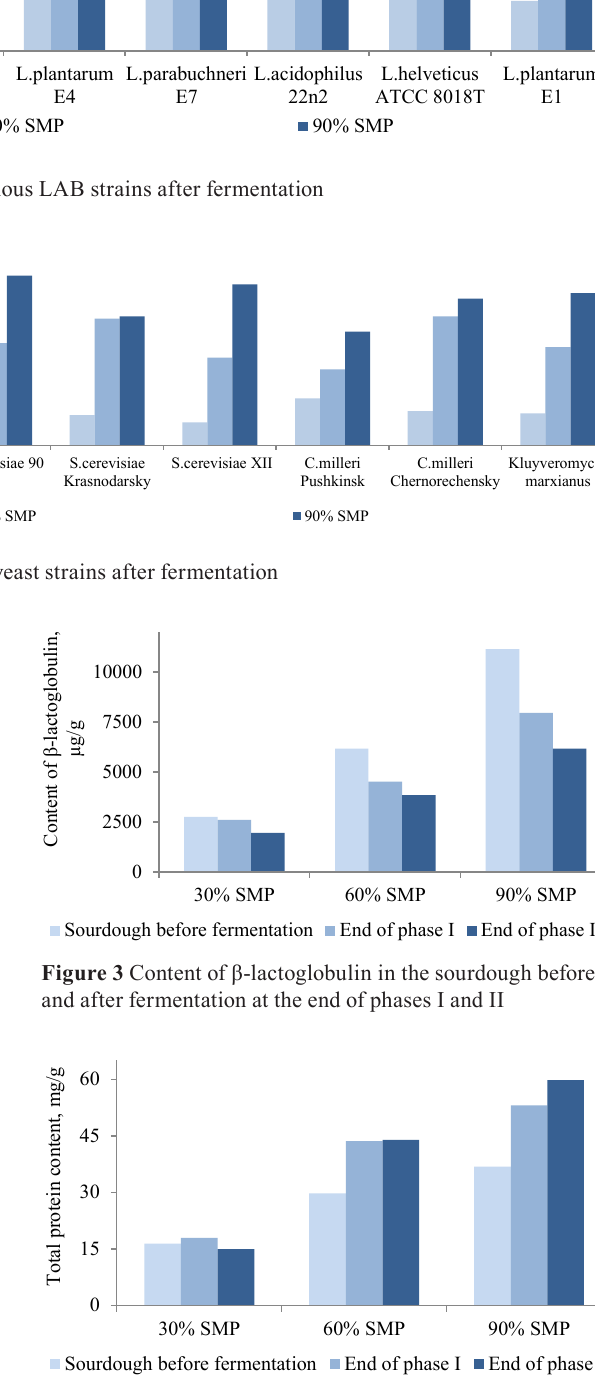
Figure 4 Total protein in the sourdough before fermentation and after phases I and